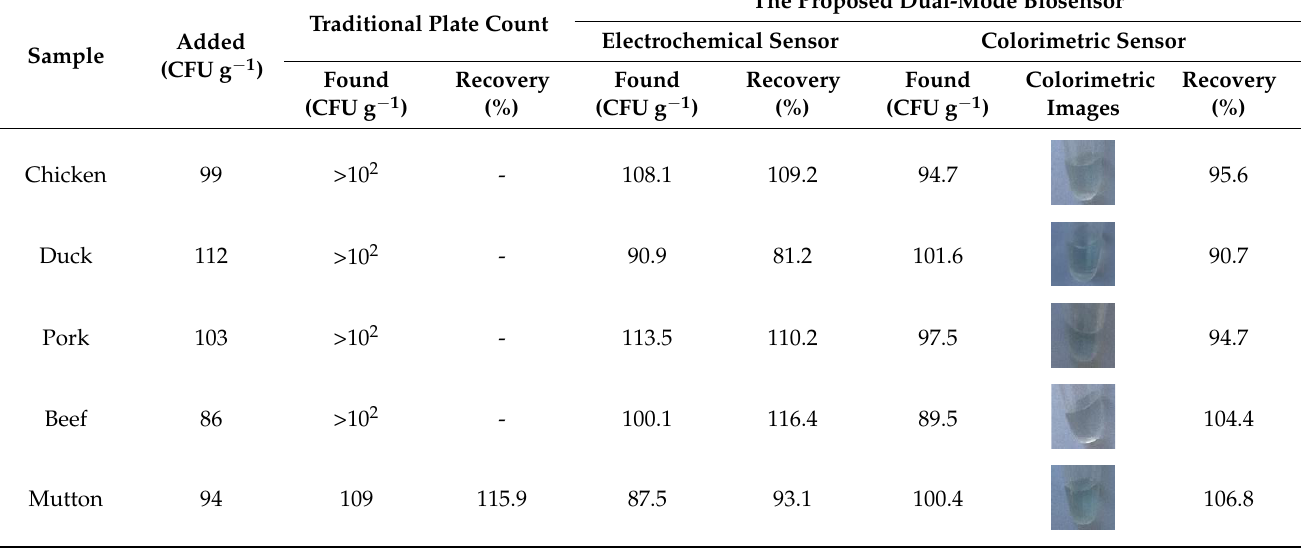
Table 3. Detection ability of P. aeruginosa biosensor in real samples.